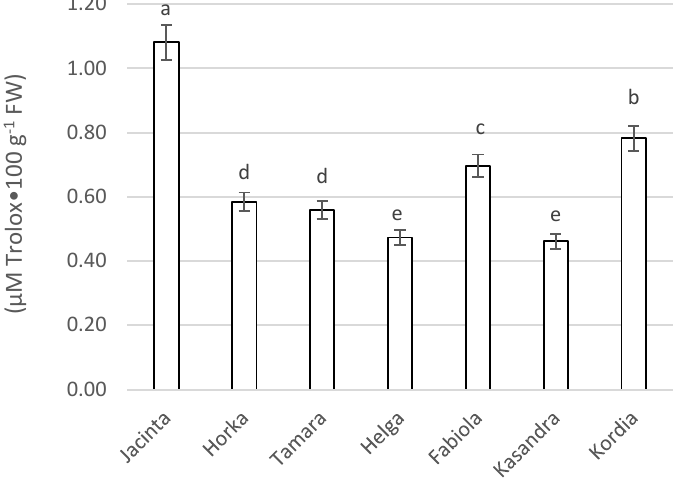
Figure 5. Antioxidant capacities, depending on cultivar. Values with different letters are significantly different.